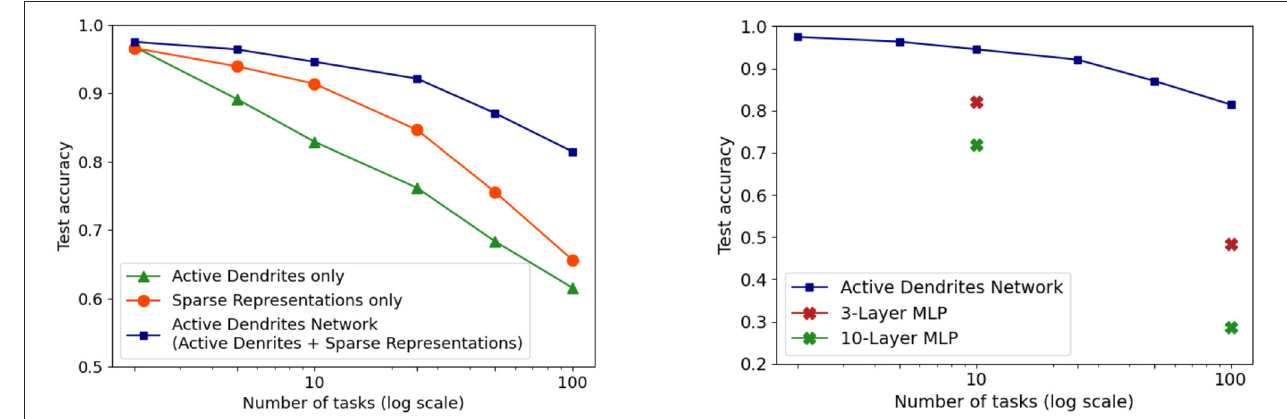
FIGURE 12 | (Left) Continual learning test accuracy on permutedMNIST using active dendrites and dense representations (green), regular ANNs with sparse representations (orange), and Active Dendrites Networks (blue) which use both active dendrites and sparse representations. (Right) Continual learning test accuracy for our Active Dendrites Network compared to regular feedforward networks with more layers. Our Active Dendrites Network has three layers; the two hidden layers contain neurons modulated by dendritic segments. In all experiments (left and right subfigures), we average results over 8 independent runs, each with a randomly initialized seed, and omit standard error bars as they highlight a very small range.